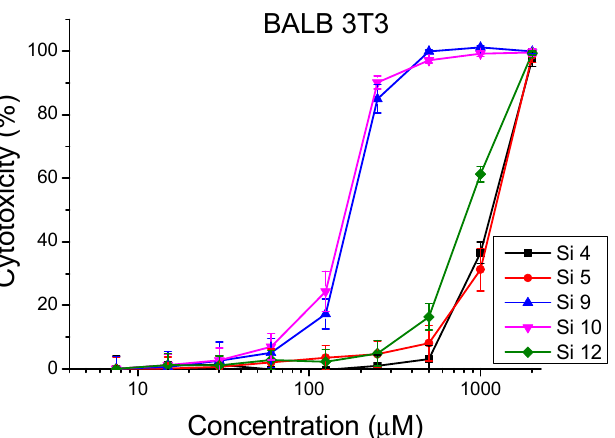
Figure 1. Cytotoxic effects of newly synthesized compounds. Dose–response curves for cytotoxicity assessment in BALB 3T3 cells. Values are means ± standard deviation from three independent experiments, n = 6. Table 2. Cytotoxic and antiproliferative activity of the studied substances expressed by IC 50 values of the mean ±